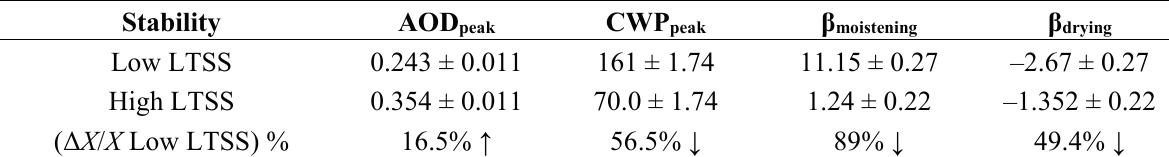
Table 8. Percent of increase ( ↑ ) or decrease ( ↓ ) in the characteristics parameters of cloud water path response curve to aerosol induced perturbation from low to high lower tropospheric static stability (LTSS) environments for NAADR_Land. Except for AOD peak observed to increase, every other parameter decreases from low to high